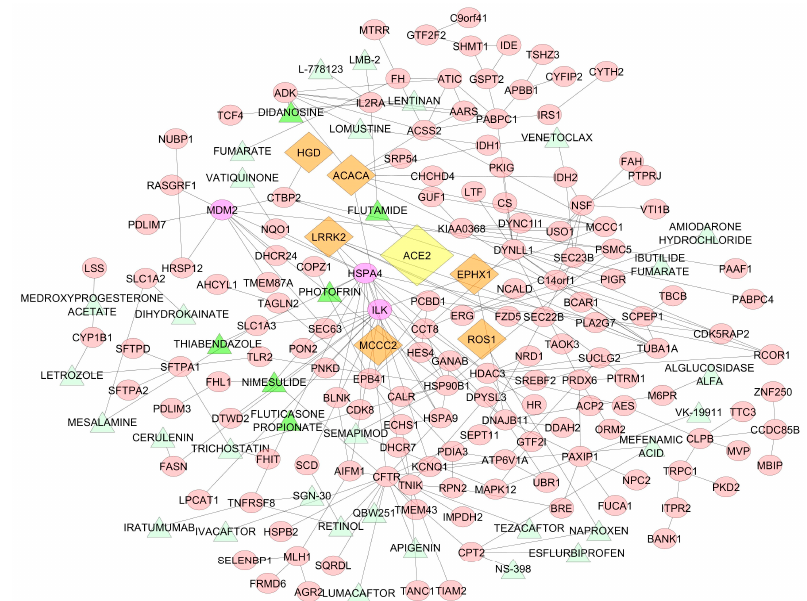
Figure 4. The figure shows the relationships between correlated genes (pink ellipse) with ACE2 (yellow diamond) and known drugs (green triangle) in a protein-protein interaction network. Top genes correlated with ACE2 are represented with orange diamond. Dark green triangles indicate the drugs associated with the genes with a high degree centrality (purple ellipse).